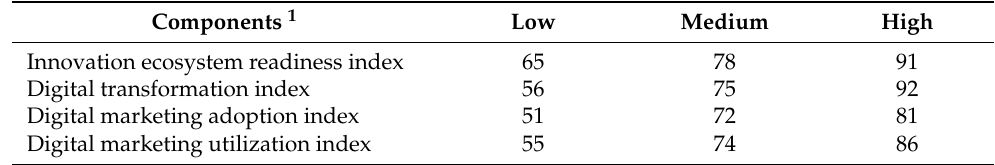
Table 6. The average index score for each company classification in